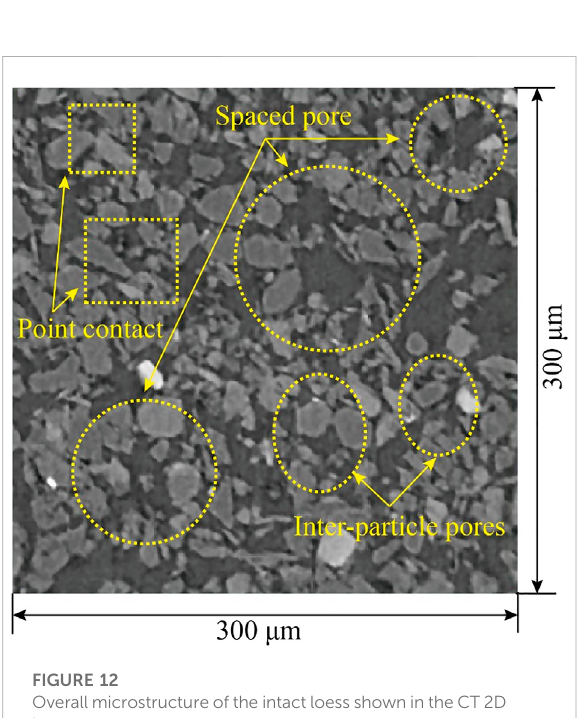
Overall microstructure ofthe intact loess shown in theCT 2D